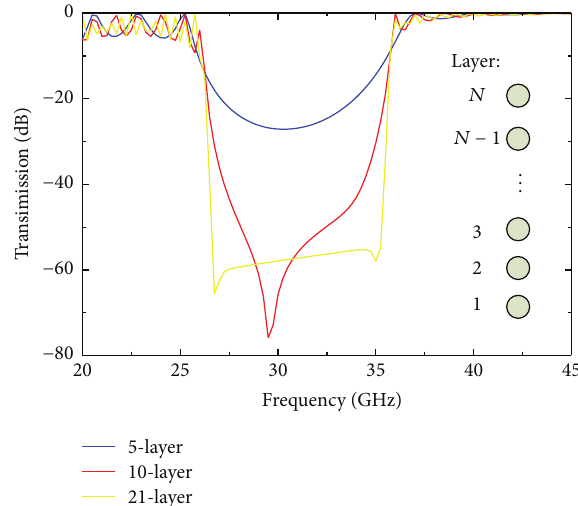
Figure 6: Transmission coefficient of multilayered PBG.